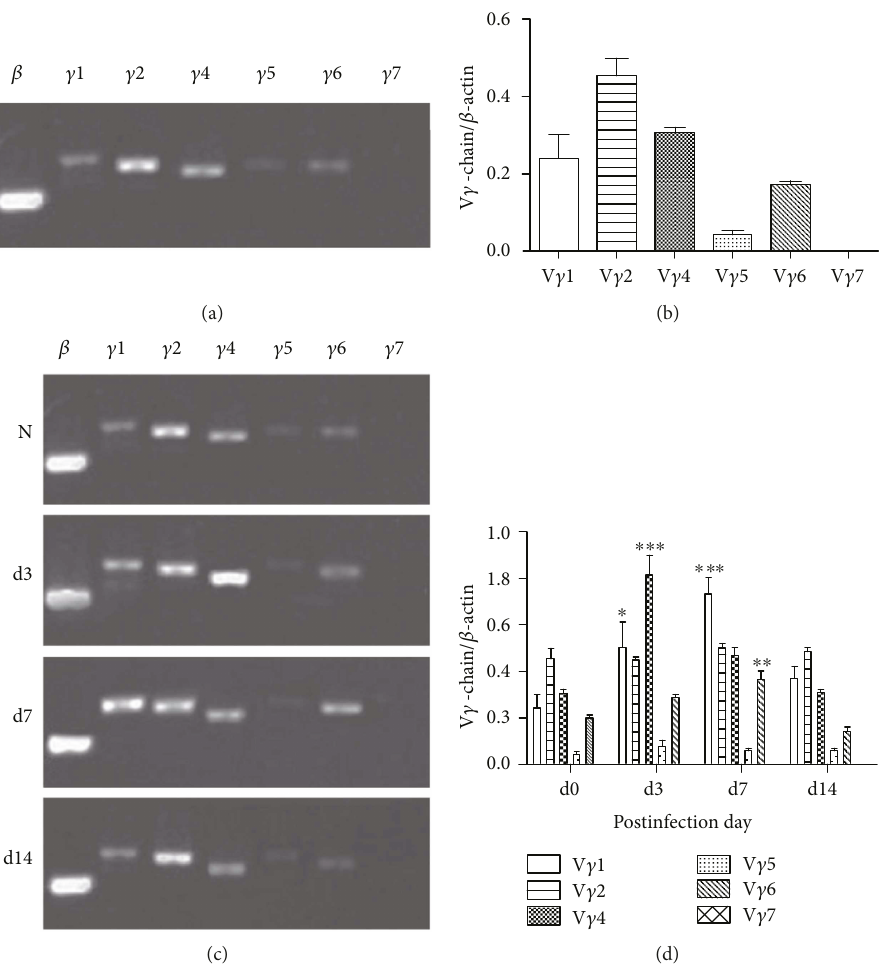
Figure 2: V γ 1+ T and V γ 4+ T cell are two main subsets of γδ T cells during Cm respiratory tract infection. The types of γδ T cell subsets from lung tissues in naïve (a, b) and infected mice (c, d) were de fi ned according to the expression of TCRV γ mRNA in lungs detected by RT-PCR. Shown are the representative data of two independent experiments with similar results presented as mean ± SD. ∗ p < 0 05 , ∗∗ p < 0 01 , and ∗∗∗ p < 0 001